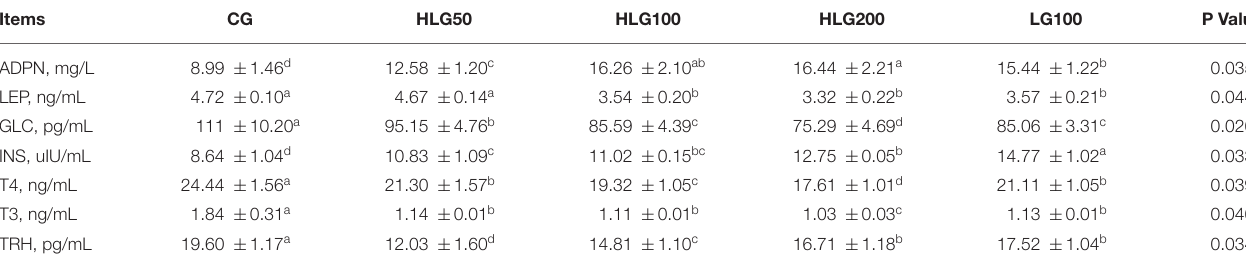
TABLE 7 | Effects of hydroxylated lecithin on hormone levels related to lipid metabolism in serum of Jiangnan White goslings. Items CG HLG50 HLG100 LG100